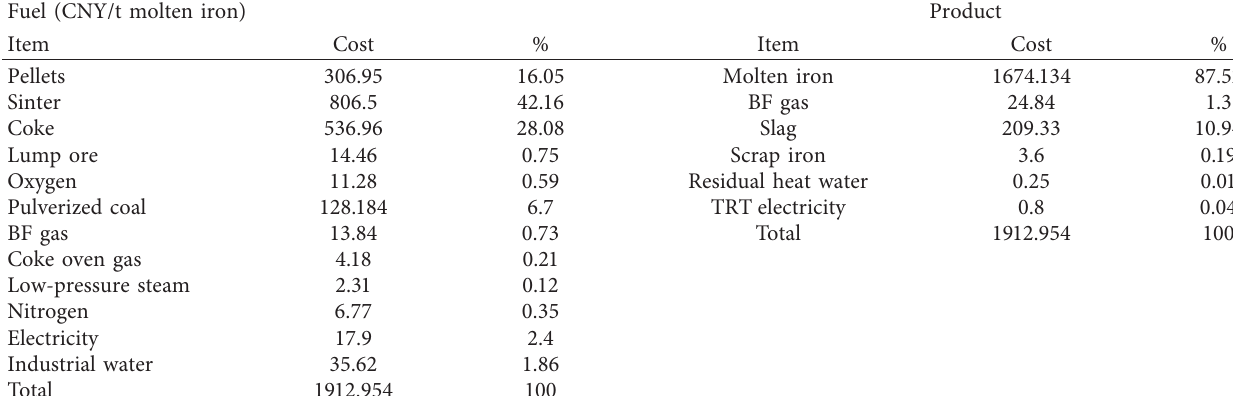
Table 5: Exergoeconomic cost with CO